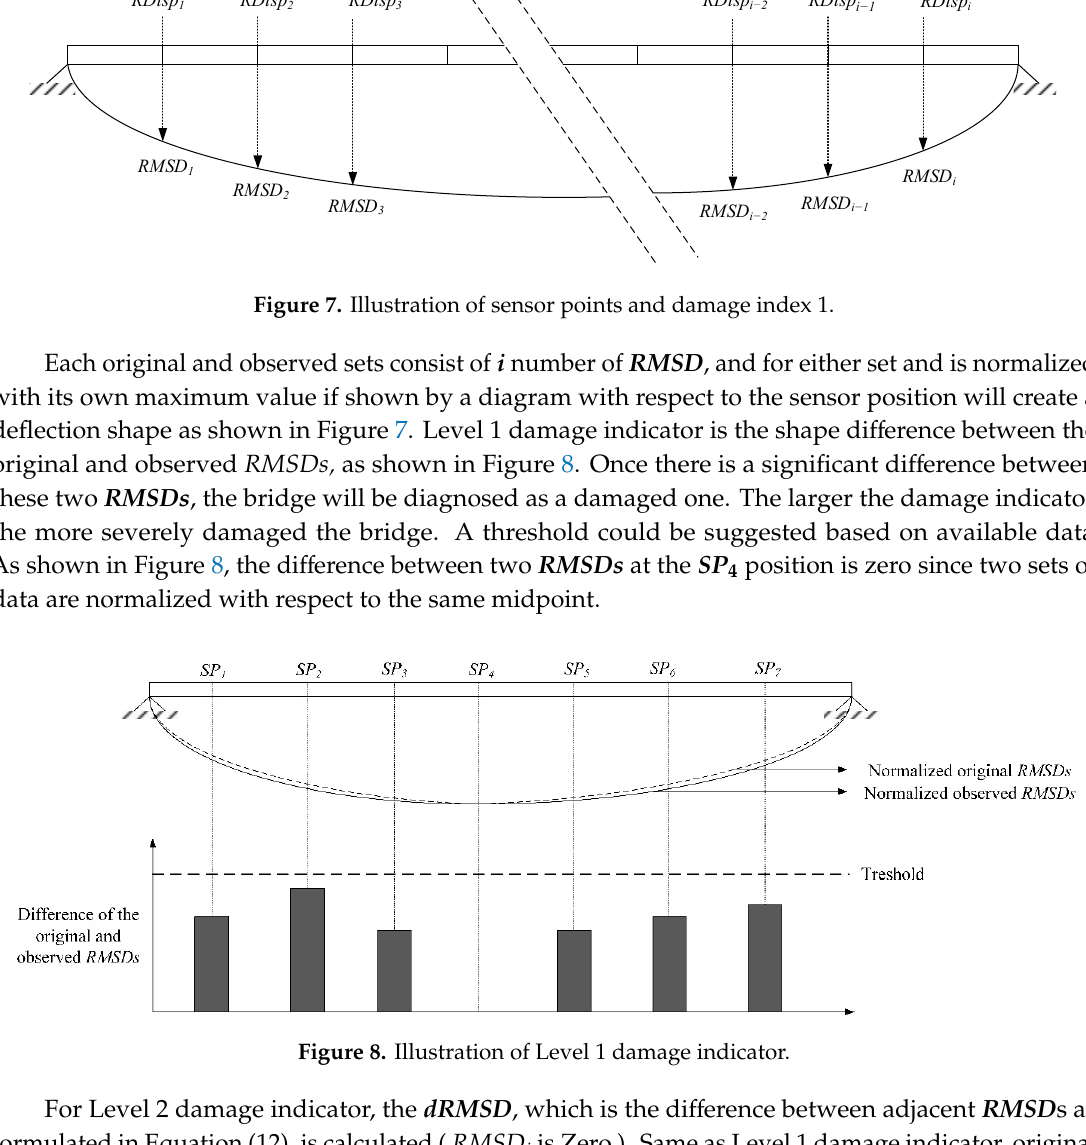
. Figure 6. General scheme of signal transmission from an on-site sensor to an off-site server. 2.3. Proposed Level 1 and Level 2 Damage Detection This section explains the proposed method that intends to detect damage occurrence and location. The proposed method utilizes the displacement reconstruction algorithm explained in an earlier section. In the bridge monitoring task, accelerometers often spread along a bridge span, as illustrated in Figure 7. Assuming that i number of sensor points (SP) spread along a bridge, as shown in Figure 7 and each sensor records acceleration data. If there is damage occurred, the collected accelerations naturally include two sets of records. Namely, the original and observed sets. These two sets of accelerations are then transformed into reconstructed displacements ( RDisp ) using Equation (10). The root-mean-square (RMS) of RDisp for each sensor point ( RMSD i ) is calculated as formulated in Equation (11). where n is the quantity of data.